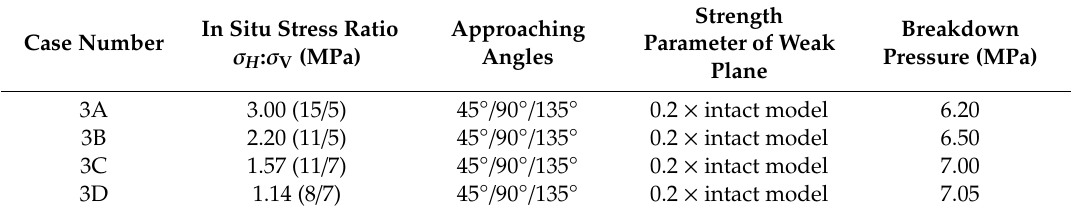
Table 6. Experimental scheme of Group 3 and results of breakdown